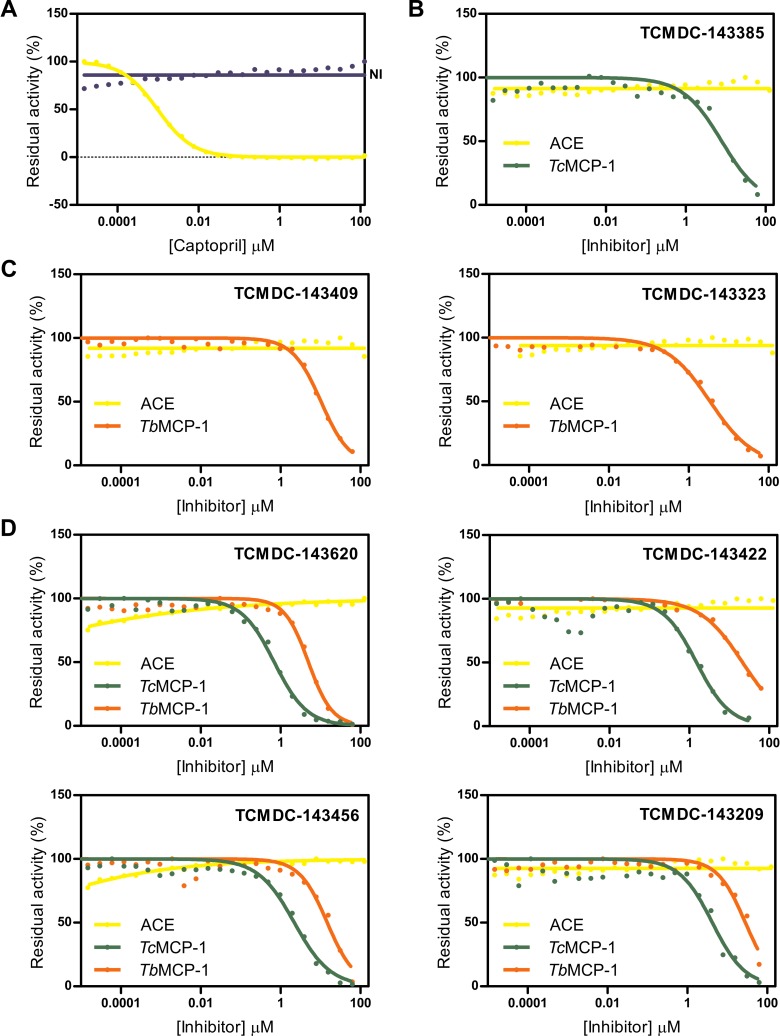
Dose-response curves for ACE.(A) Purified rabbit lung ACE was assayed at 37°C in 0,1 M Tris-HCl pH 7,0 buffer containing 50 mM NaCl, 10 mM ZnCl2 and 0,01% Triton X-100. Captopril, a potent competitive ACE inhibitor, was included as a positive inhibition control (IC50~ 1 nM). NI, no inhibitor added. (B, C) Data corresponding to TcMCP-1 and TbMCP-1 specific inhibitors, respectively. (D) Dose-response curves corresponding to those molecules that inhibited both MCPs. In all cases, solid lines represent the best fit of four-parameter Hill equation to experimental data (closed circles). Yellow, dark-green and orange colors were used for ACE, TcMCP-1 and TbMCP-1, respectively.